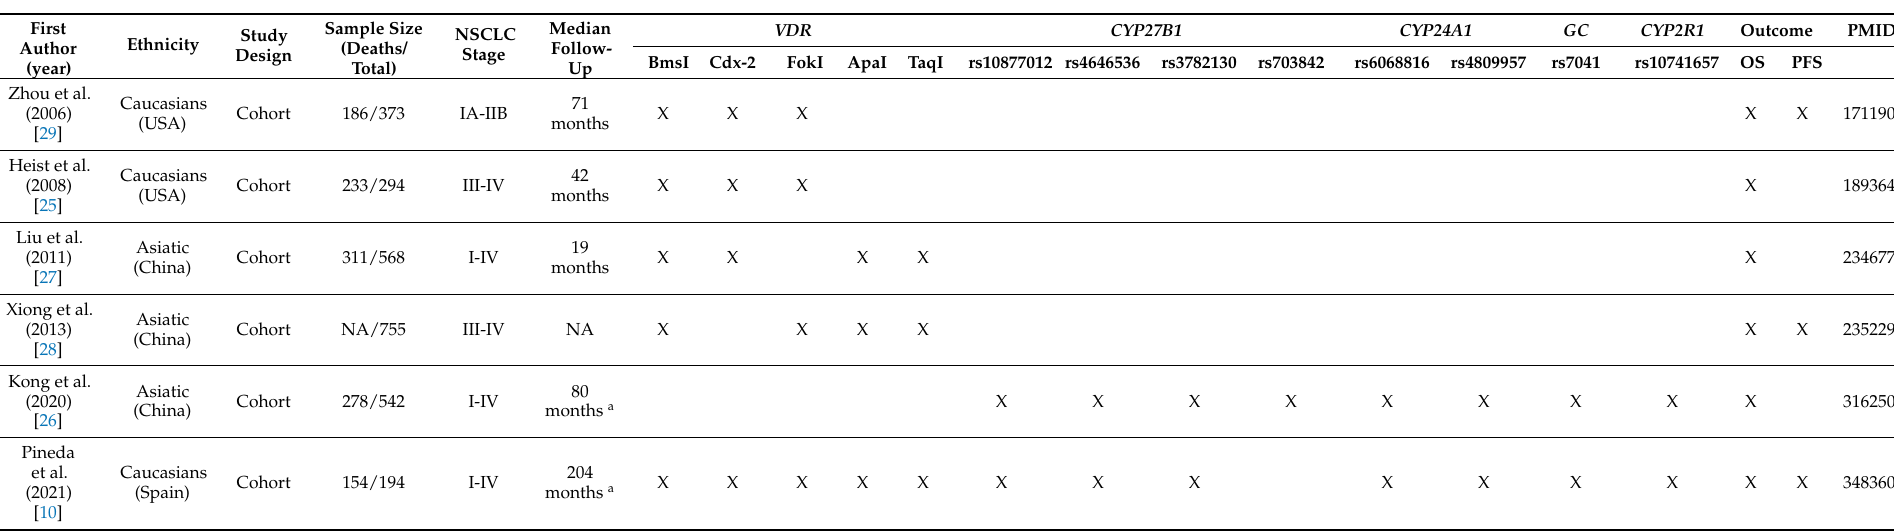
Table 2. Characteristics of the included PGx